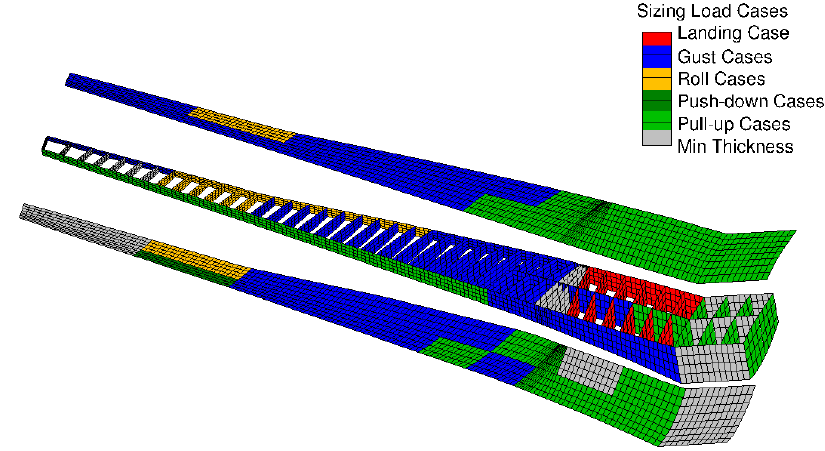
Figure 27. Sizing load cases for each design field—MLA + GLA.